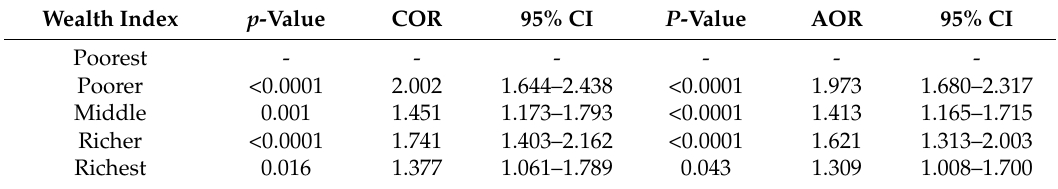
Table 5. Association between household wealth index and overall life satisfaction, Nepal MICS 2014. Wealth